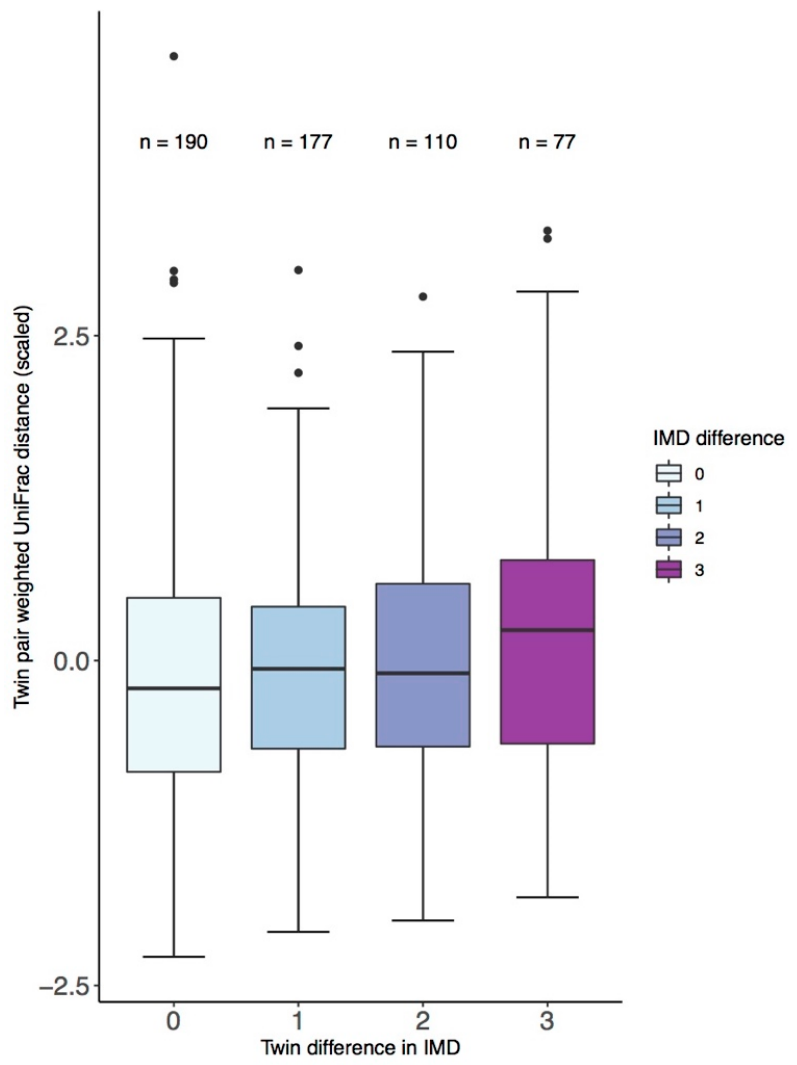
Figure 4. Between twin-pair weighted UniFrac distance and difference in quintile grouping of the Index of Multiple Deprivation (IMD).